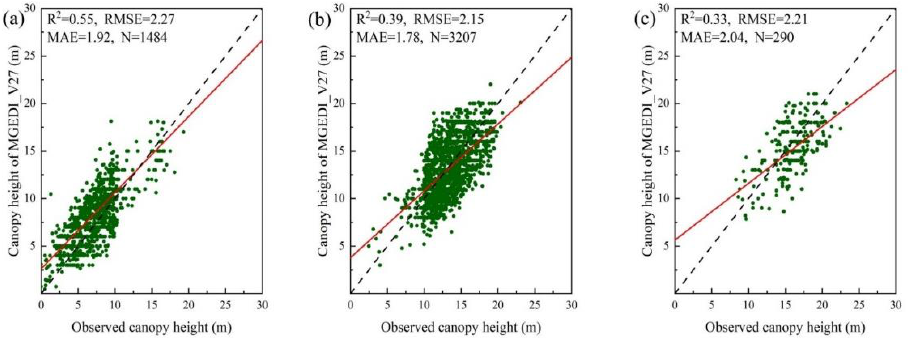
Figure 16. Canopy height accuracy for the three age groups of the MGEDI_V27. ( a ) Young stands (0–10 years). ( b ) Middle-aged stands (10–20 years). ( c ) Mature stands (more than 20 years).